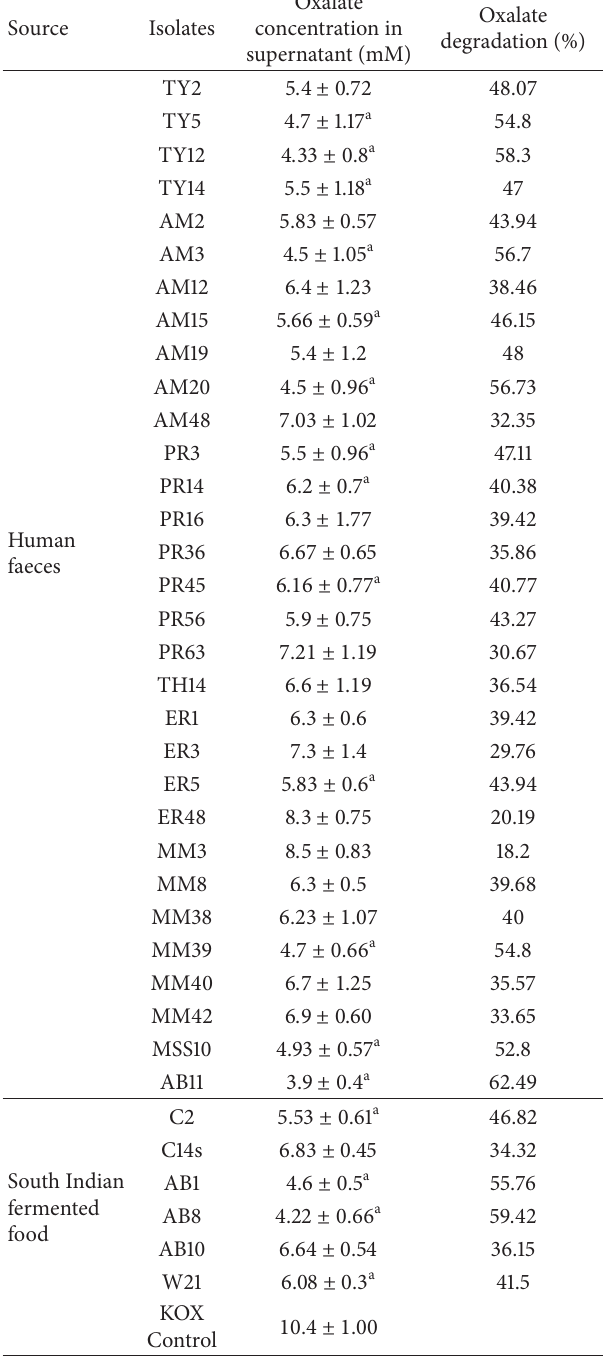
Table 1: Determination of oxalate degrading ability of LAB